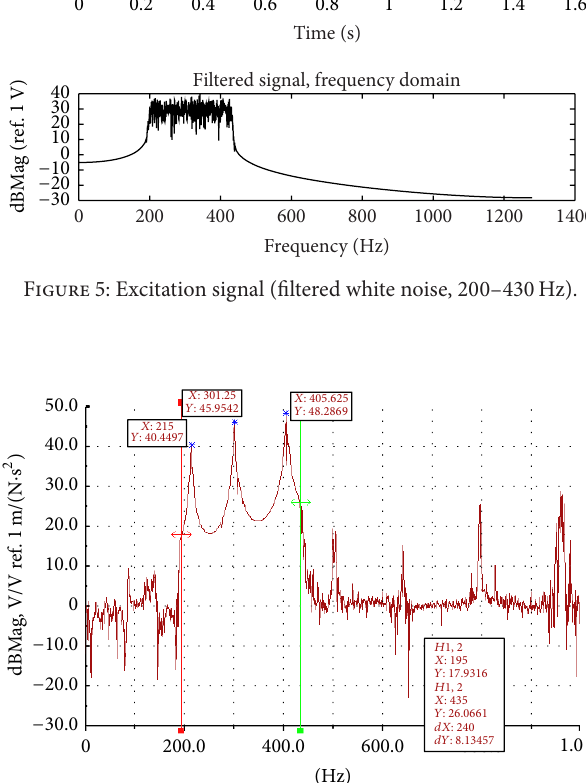
performed, in order to have the FXLMS algorithm fully implemented, as portrayed in Figure 3. Those paths are identified through offline procedures [29] and the digital filter associated with each path represents the corresponding impulsive response. These filter coefficients are loaded into the algorithm and kept constant, describing thus “static filters” during the control